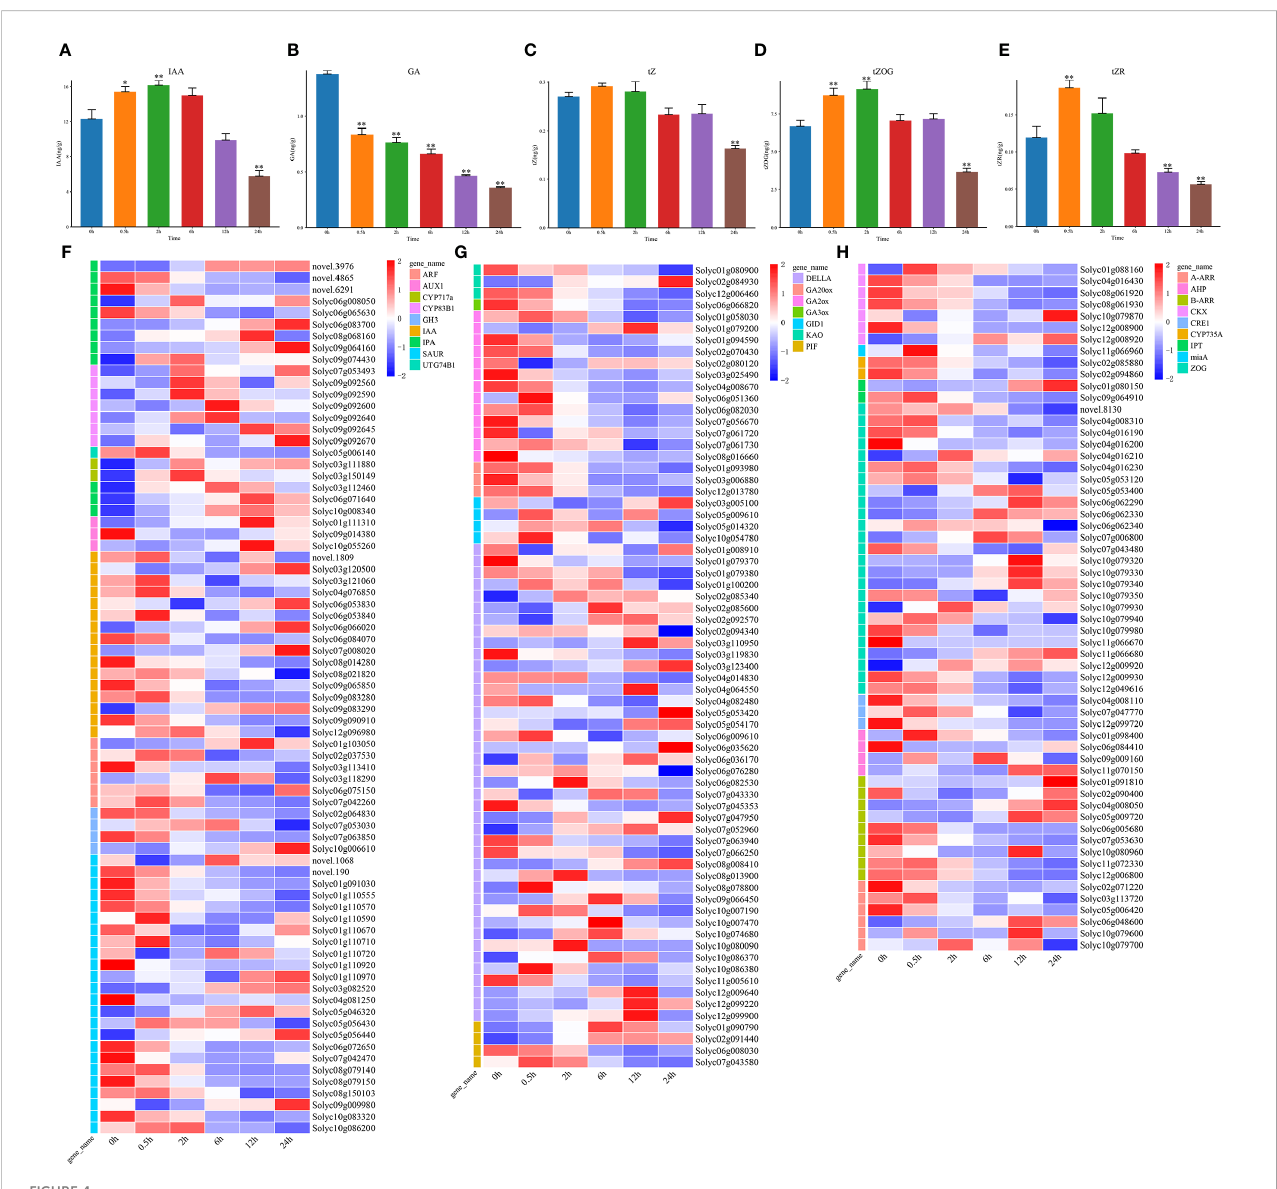
FIGURE 4 The changes in hormone IAA, GA, and tZ contents and expression patterns of genes involved in hormone biosynthesis and signal transduction under salt stress. (A) The hormone IAA levels at DTP under salt stress (B) The level of hormone GA at DTP under salt stress (C – E) The tZ, tZR, and tZOG hormone contents at DTP under salt stress (F) Expression patterns of DEGs involved in signal transduction and IAA production at DTP under salt stress (G) The expression pro fi les of DEGs involved in GA biosynthesis and signal transduction at DTP under salt stress (H) the expression pro fi les of DEGs involved in tZ biosynthesis and signal transduction at DTP under salt stress. (* P -value < 0.05; ** P -value <